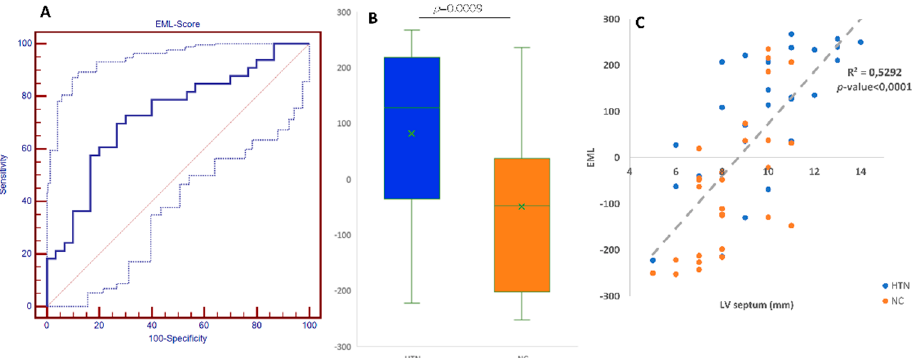
Figure 3. ( A ) Area under the receiver operating characteristic curve of the EML score (0.731 ± 0.064) ( p -value < 0.001; ( B ) EML-score distribution among the HTN and NC patients; means values resulted 82.0 ± 155.9 and − 49.1 ± 152.7, respectively ( p -value < 0.001); ( C ) Correlation among LV septum width (mm) and Ensemble Machine Learning Score (R 2 = 0.5292, p -value < 0.0001). The EML score was also evaluated in diabetic and non-diabetic enrolled subjects